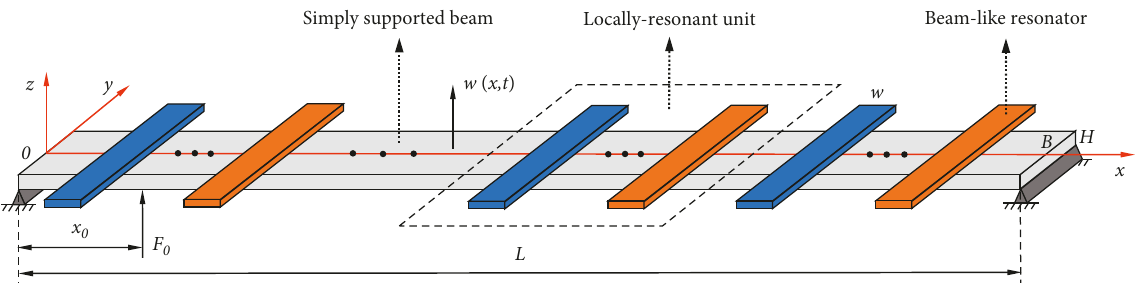
Figure 1: A dynamic model of the finite locally resonant